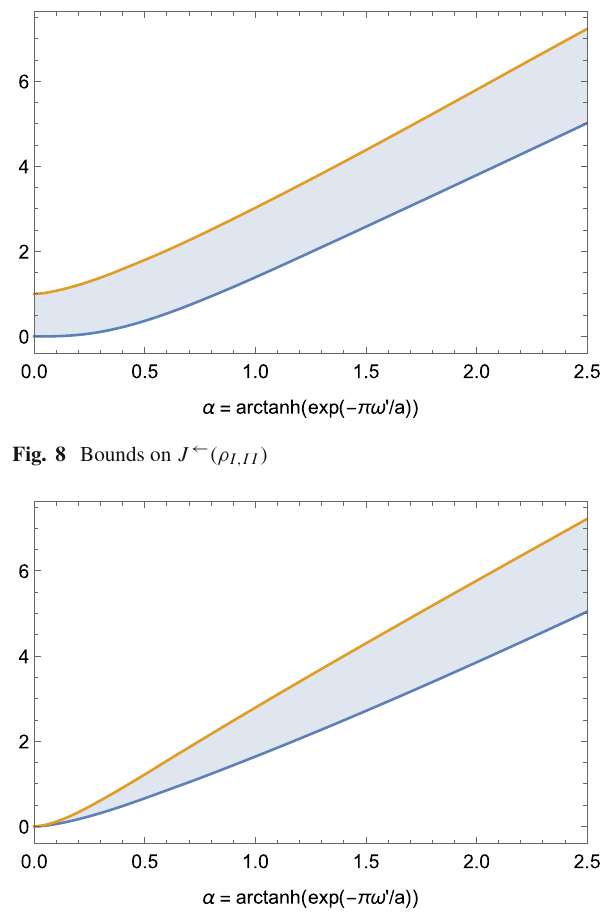
Fig. 9 Bounds on J → (ρ I , II